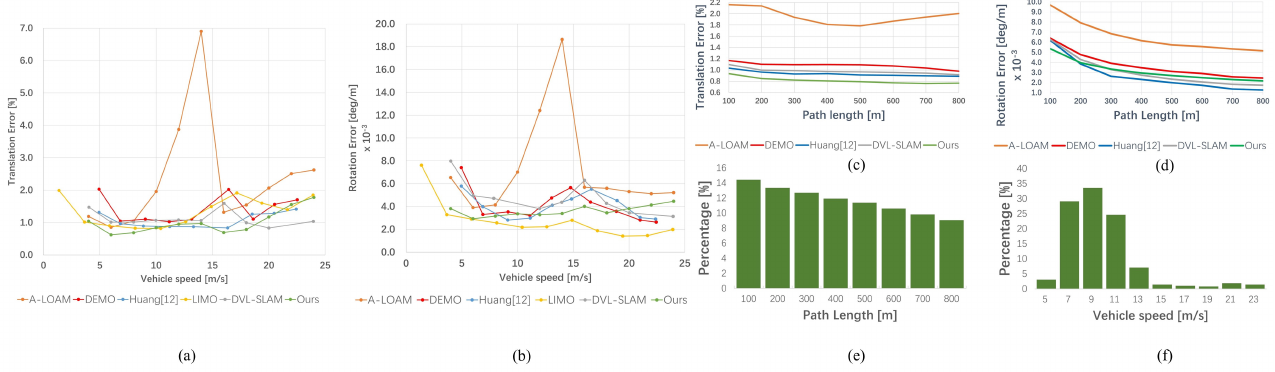
Figure 13. The error analysis performed on the KITTI training dataset between A-LOAM, DEMO, DVL-SLAM, LIMO, Huang et al. [35], and Ours. Since we only obtain error curves related to vehicle speed ( a , b ) of LIMO, we show A-LOAM, DEMO, DVL-SLAM, Huang [35], and our error curves in terms of path length ( c , d ). The ( e , f ) show the percentage of different path segment length and vehicle speed in.